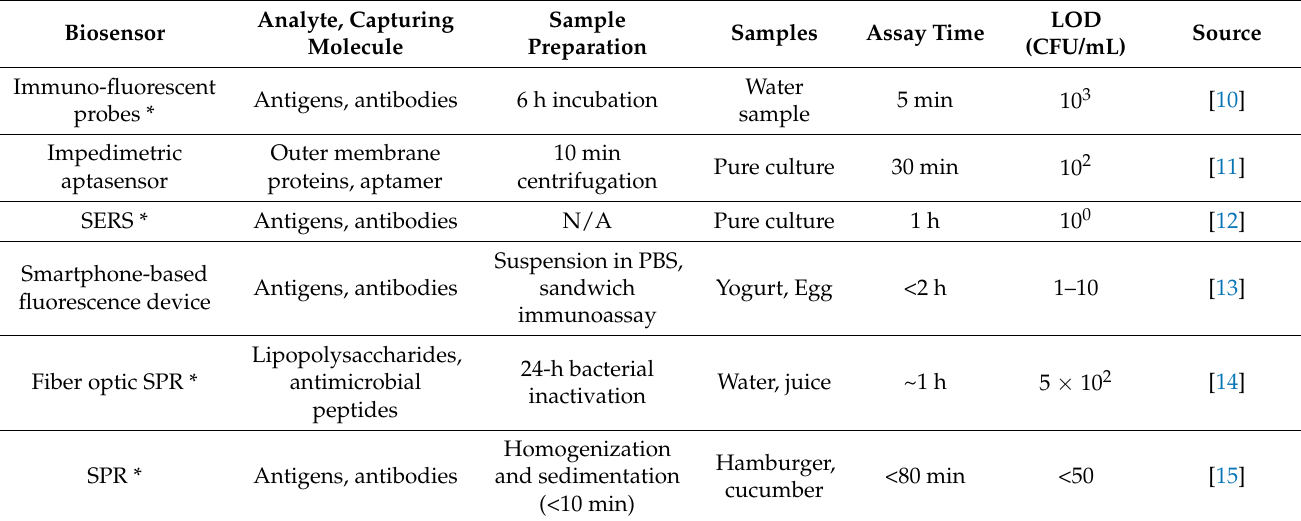
Table 1. Summary of recent biosensor developments for E. coli